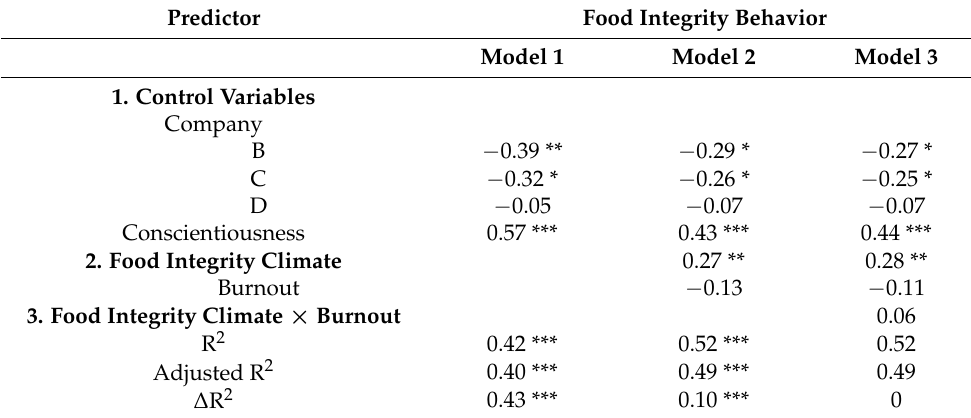
Table 5. Hierarchical linear regression of the moderator burnout ( n = 118 participants). Standardized regression coefficients for the respective regression steps are reported. Conscientiousness, food integrity climate and burnout are centered around the mean (* p < 0.05, ** p < 0.01, *** p < 0.001; Company A is reference category). Hypothesis 2B was rejected, since burnout appeared not to have a moderating effect in the relation between food integrity climate and food integrity behavior. Predictor Food Integrity Behavior Model